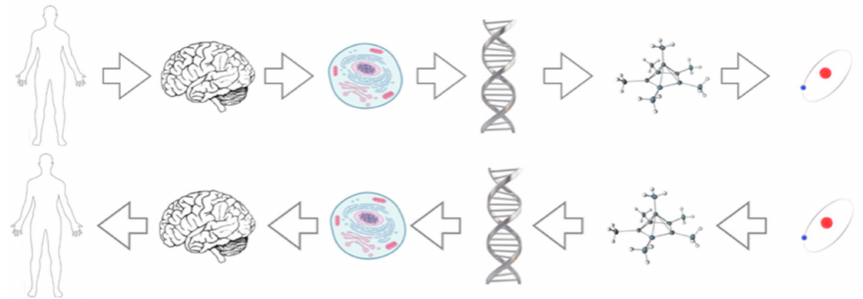
Figure 1. Reductionist versus holistic approaches. In the reductionist approach phenomena are separated and isolated into their component parts in order to understand the mechanisms unique to that level of reality. In contrast, in the holistic approach phenomena are connected and linked into networks or groups in order to understand the qualitative properties that emerge at higher level orders of reality. From the reductionist approach higher level phenomena are reducible to lower level phenomena, and from the holistic approach higher level phenomena can only be understood on the terms of their own emergent properties.